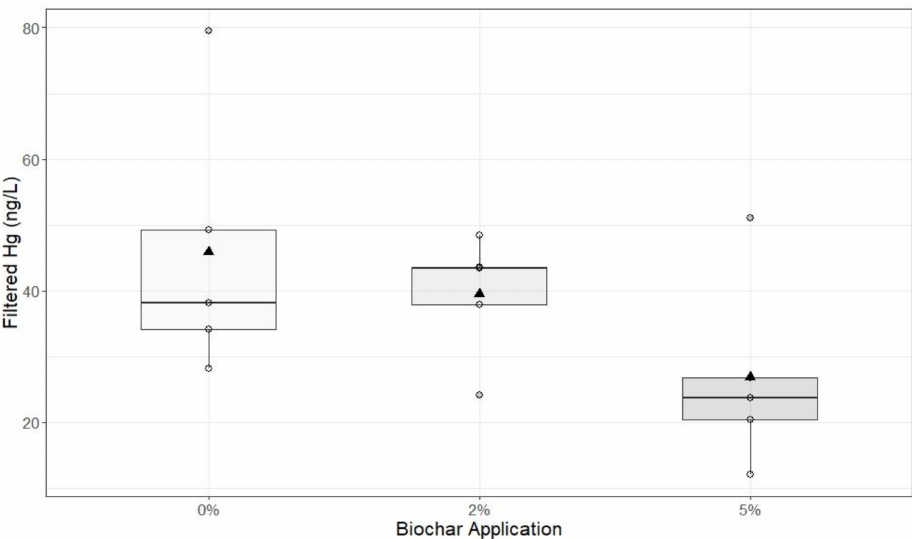
Figure 6. Filtered mercury in Experiment 2. Triangles indicate mean, bars show quartiles and standard deviation. Application of biochar at 2% and 5% by weight did not significantly reduce filtered Hg in the outflow after 24 h ( p > 0.05, n =